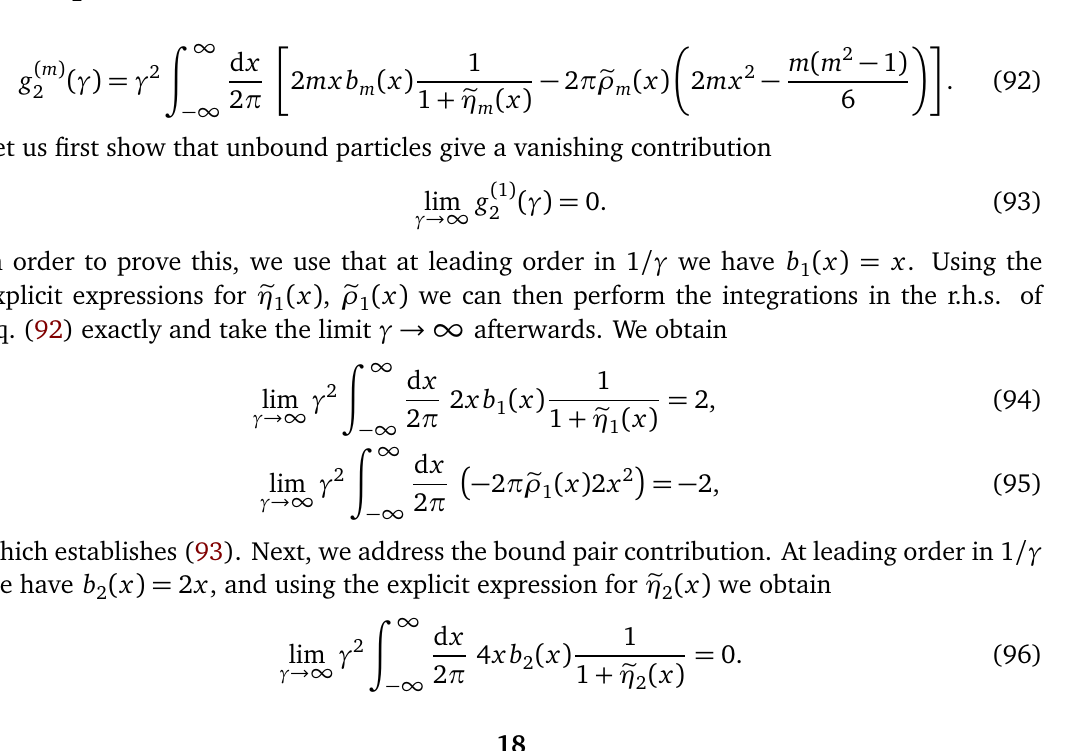
and absolute value of the normalized energies per volume e n | = − e > for n ≥ 2) while e n n 1